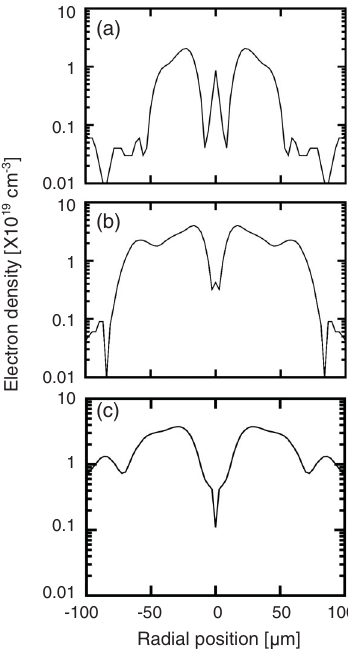
FIG. 11. Transverse electron density distribution at different positions: A, B, and C as in Fig. 8(d).